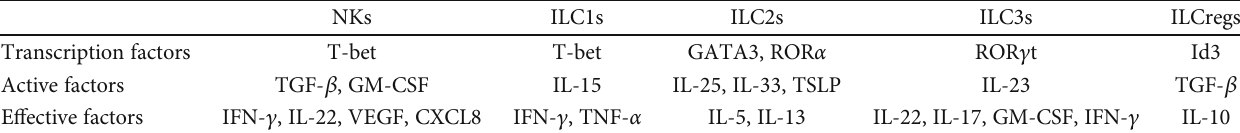
Table 1: Characteristics of intestinal innate lymphoid cells